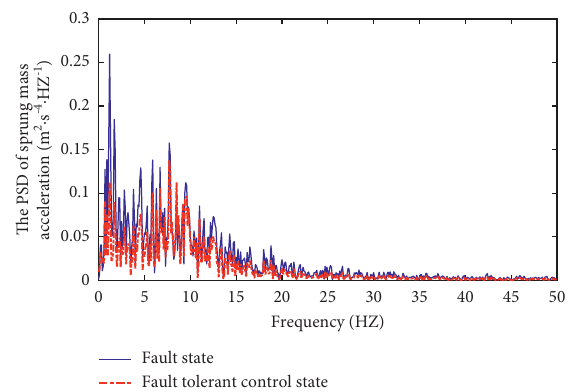
Figure 18: The frequency-domain response of the sprung mass acceleration